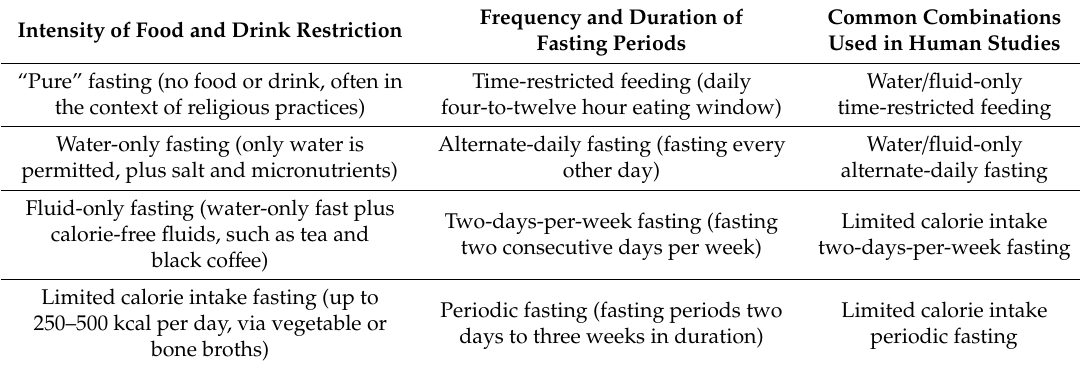
Table 1. Human fasting regimens (by intensity, frequency, and